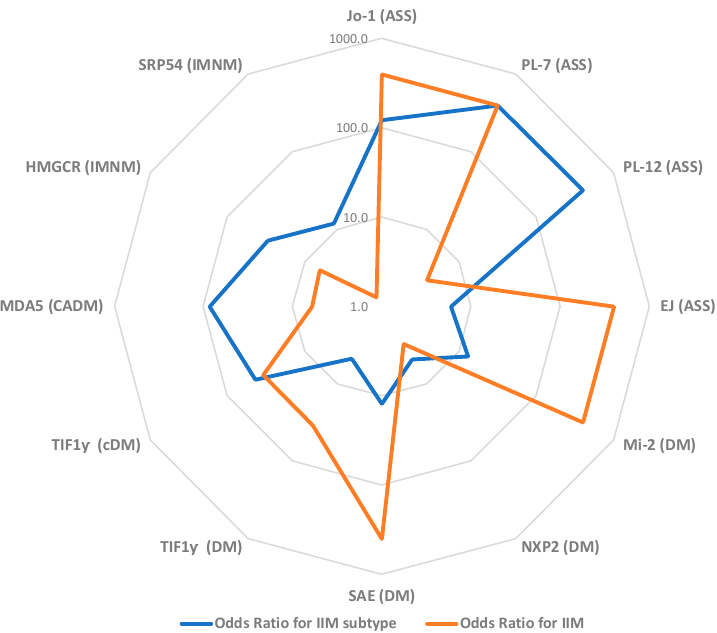
Figure 5. Odds ratio plot of myositis specific antibodies (MSA) in diagnosis and sub-setting of idiopathic inflammatory myopathies (IIM). For markers with very high (infinity) odds, ratios were replaced by a nominally high value of 400 to depict the relative utility of various MSA in the diagnosis of IIM and IIM subtypes. TIF1 γ is represented two times (DM and cDM) for IIM; axis for the plot is in log scale. Abbreviations: ASS = Antisynthetase syndrome; DM = dermatomyositis; cDM = cancer associated DM; CADM = clinically amyopathic dermatomyositis; IMNM = immune mediated necrotizing myopathies.